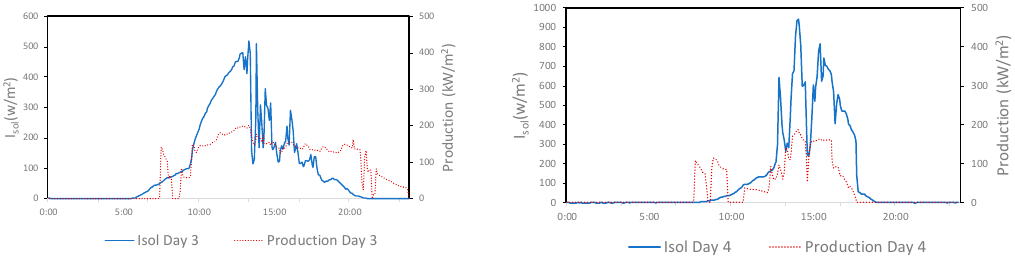
Figure 17. Experimental results for the irradiance and the solar production during Days 3 and